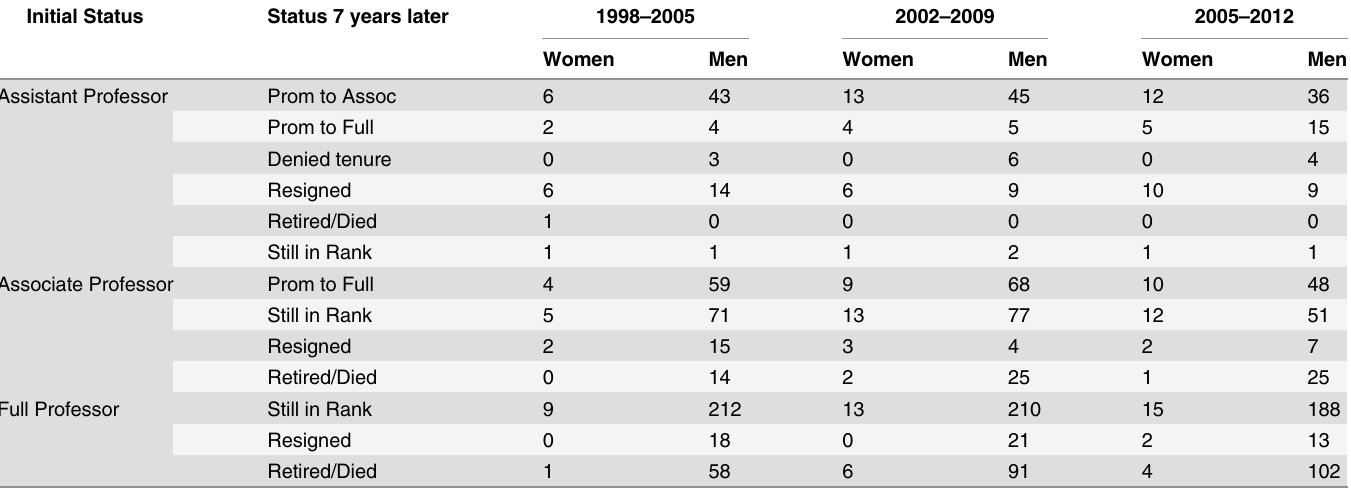
Table 1. Numbers of individual faculty used to compute transition matrix data for the three cohorts. Initial